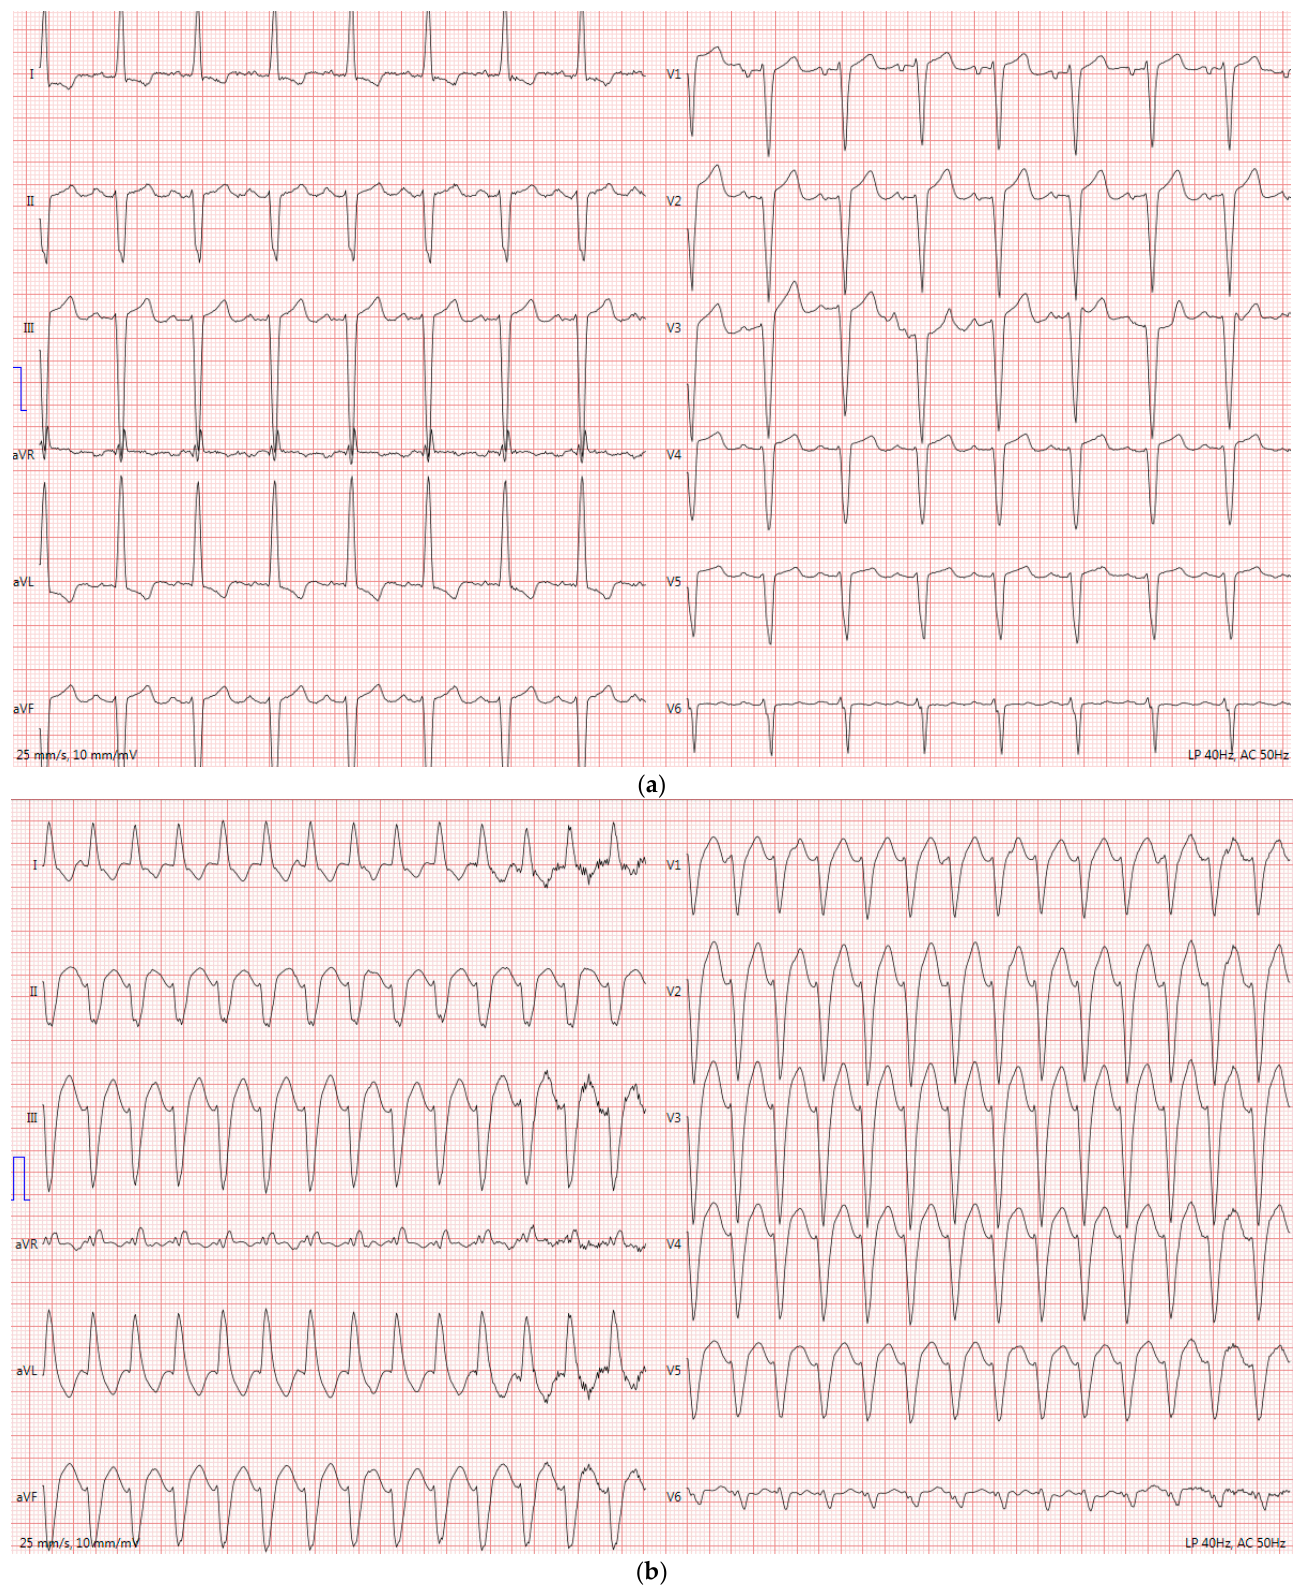
Figure 1. ECG comparing sinus rhythm ( a ) and bundle branch re-entrant tachycardia ( b ).